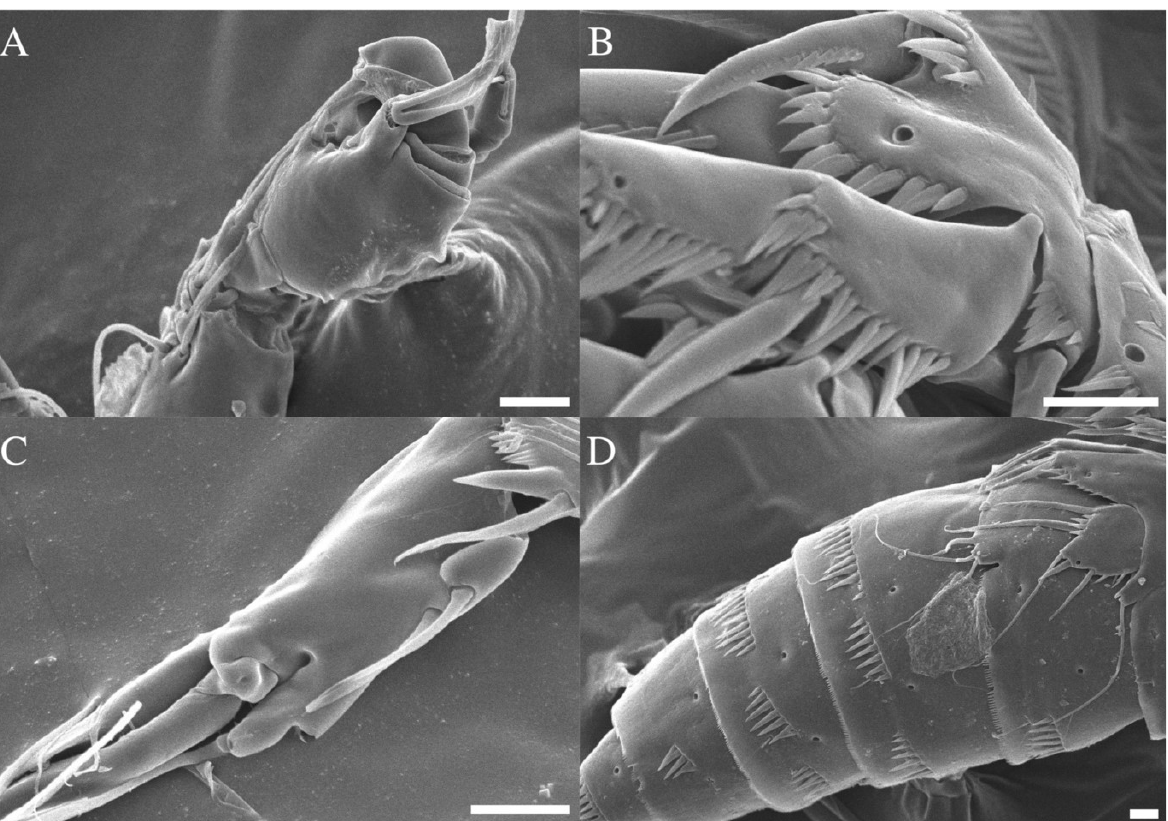
Figure 9. Robertgurneya jejuensis sp. nov. Male. SEM photographs. ( A ) A1. ( B ) P1 basis. ( C ) P2 enp- 2. ( D ) Urosome, lateral. Scale bars: 10 μm. ( D ) Urosome, lateral. Scale bars: 10 µ